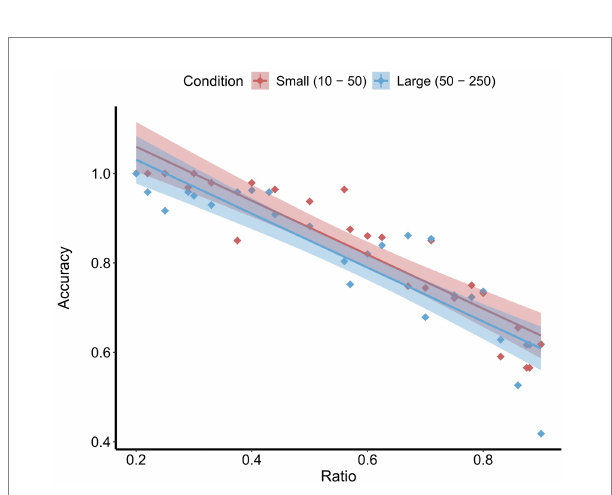
FIGURE 2 Mean accuracy by ratio on the control trials for both the small and large conditions. Shaded areas represent the 95% confidence